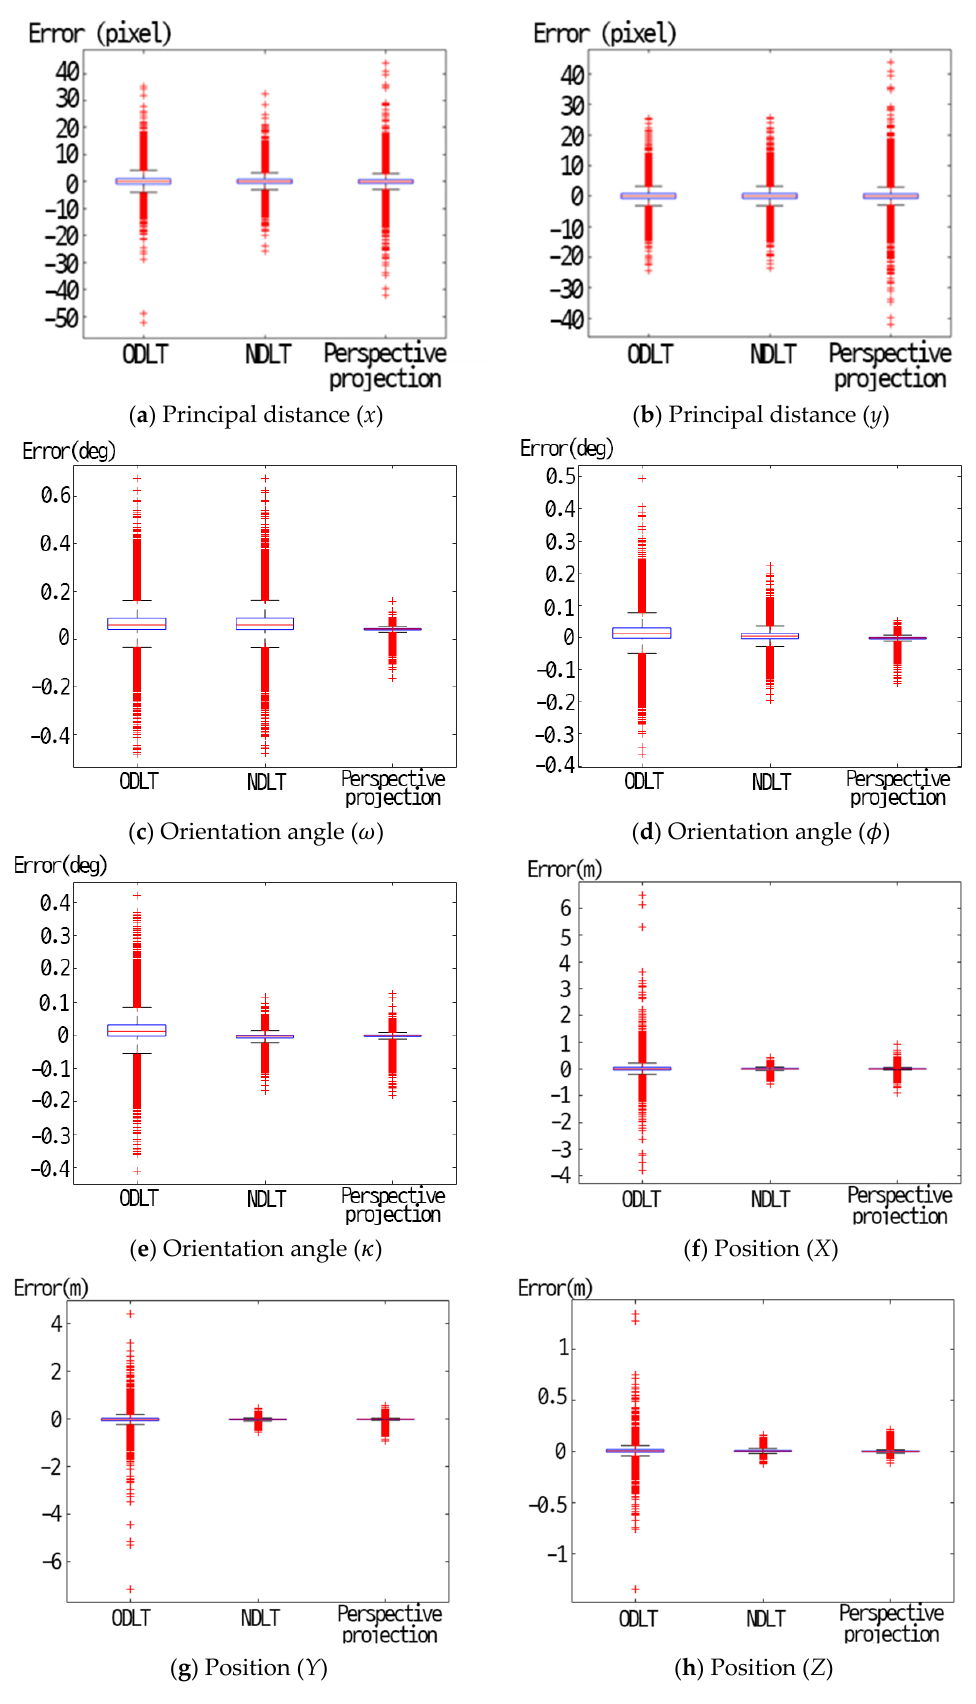
Figure 7. Accuracy assessment results using a 10 × 10 × 10 virtual grid. Figure 8 shows box plots of the mean reprojection error of each algorithm. When comparing the mean reprojection error, ODLT showed outstanding performance. The maximum error of the ODLT model did not exceed 0.5 pixels. NDLT and Perspective pro- jection models also showed good performance, but the maximum errors were 1.71 pixels and 3.72 pixels, respectively. Figure 8. Box plots of mean reprojection error results. It is interesting to note that the X, Y, and Z distributions of GCP also affect the quality of the estimation results. Aside from the distribution of GCPs on the image plane, the even distribution of GCPs in a 3D object space is critical [36,37]. GCPs were randomly selected on one plane as shown in Figure 9a, and GCPs were randomly selected on multiple planes as shown in Figure 9b, and the results were compared.